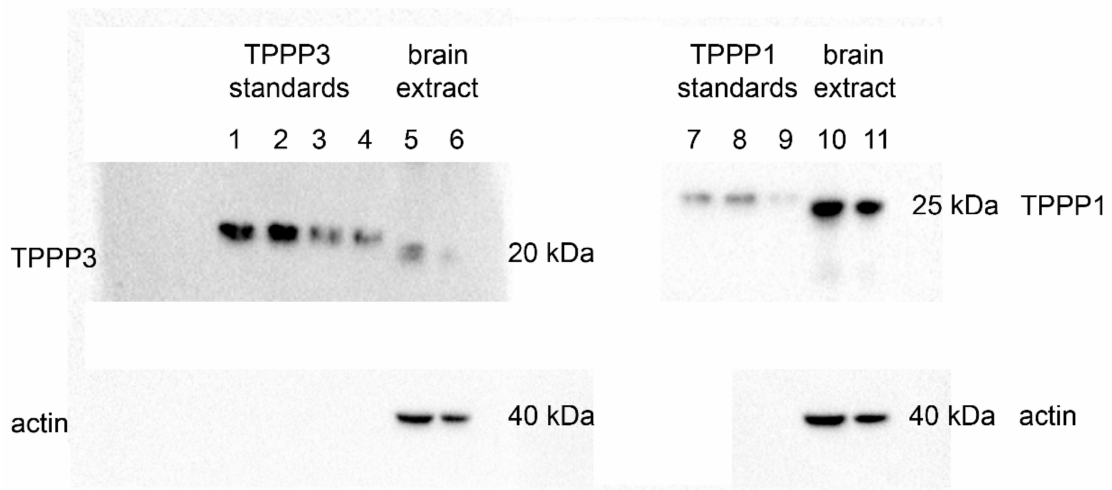
Figure 2. TPPP3 and TPPP1 levels in human brain as determined by Western blot using monoclonal TPPP3 antibody and polyclonal TPPP1 antibody. Both recombinant TPPP1 and TPPP3 containing His-tag (lanes 1–4 and 7–9) and brain extracts (22 and 11 µ g total protein of the extracts on lanes 5/10 and 6/11, respectively) were loaded to the gel and subjected to Western blot. TPPP3 standards: 40, 32, 24 and 16 ng (lanes 1–4), TPPP1 standards: 16, 12 and 8 ng (lanes